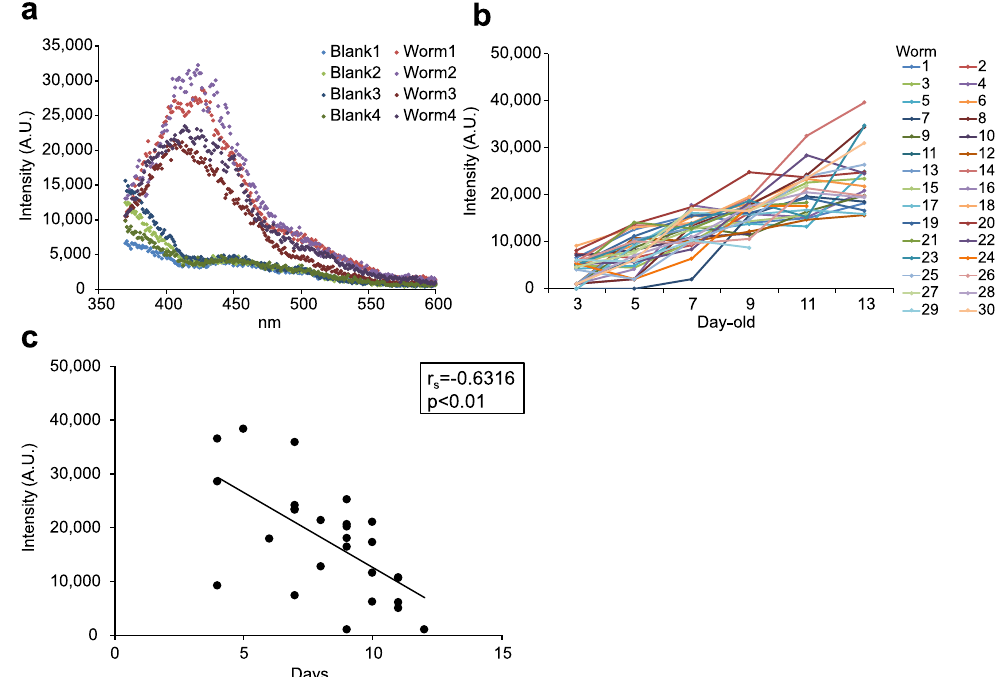
Fig. 3 Fluorescence spectrophotometry of individual worms measured by the noninvasive wrap-drop method. Randomly selected worms (wild-type N2) were washed with M9 buffer and then placed in 1.0 µL of M9 buffer on cling fi lm stretched over a 384-well black plate. The auto fl uorescence in the body of each worm was captured with a multimode grating microplate reader to test whether the fl uorescence was detected not only from extracted proteins but in living worms. a Data for four 13-day-old worms were produced by a fl uorescence spectrophotometer (ex 340/em 360 – 600). The highest fl uorescence was found at a similar wavelength for auto fl uorescence of extracted proteins. b Changes in fl uorescence intensity of individual worms over time from 3 days old to 13 days old (ex 340/em 430). After measurement, each worm was individually maintained on a plate covered with OP50 at 25 °C. Each assay was carried out on a minimum of 20 worms and repeated twice; data for worms that died within 2 days were omitted to exclude the in fl uence of death fl uorescence. c Life expectancy of each 13-day-old worm was inversely associated with the intensity of auto fl uorescence (ex 340/em 430). Auto fl uorescence of 13- day-old worms ( n = 27) was measured, and each intensity was plotted against the period (days) that the worm survived afterward. r s indicates Spearman ’ s rank-correlation coef fi cient. The p value was calculated using the test of no